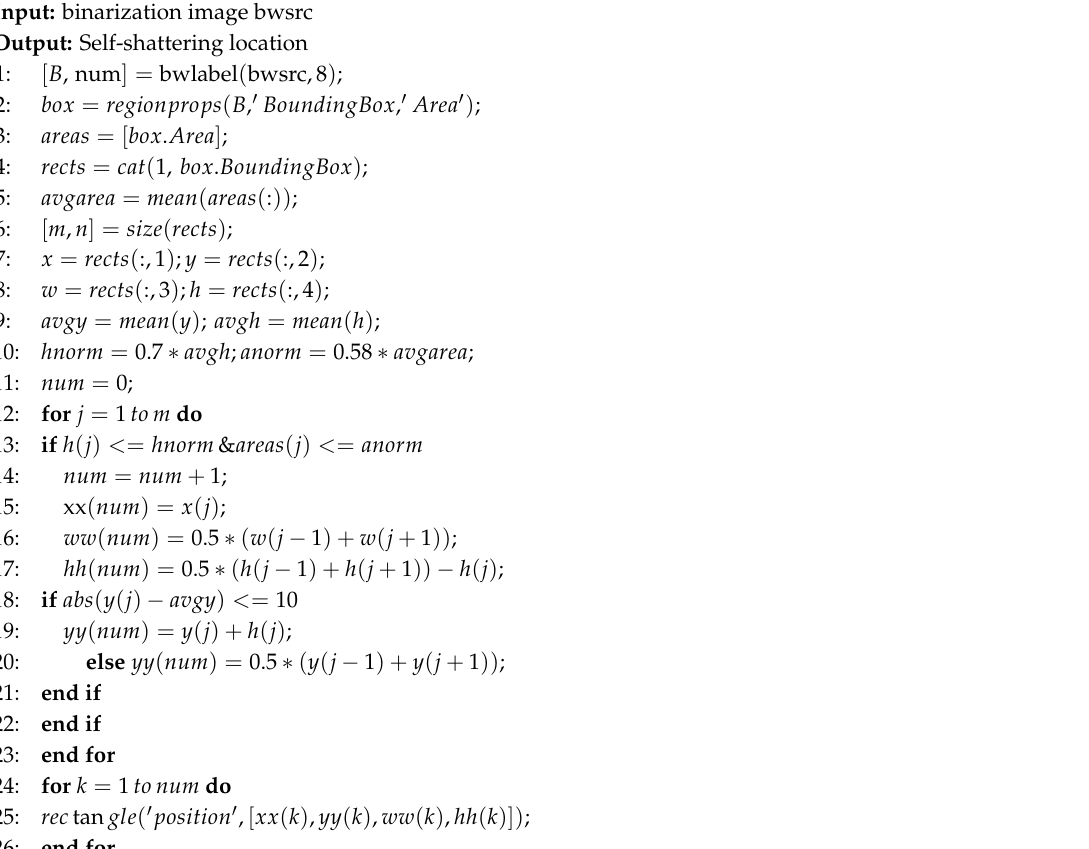
Algorithm 1. Self-shattering detection process with obstructed.